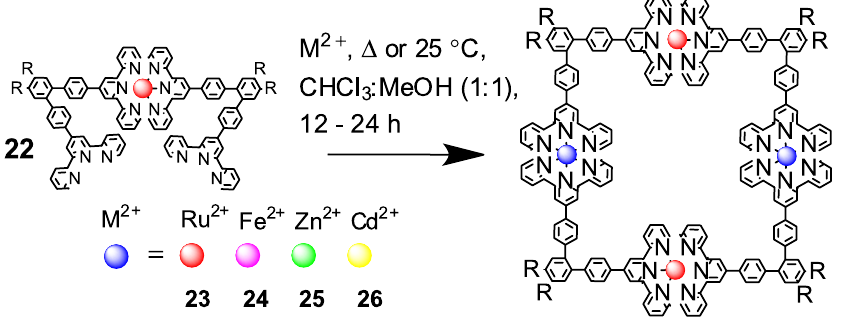
FIGURE 11 - Synthesis of a series of square-shaped metallocycles using a modified bis terpyridine to avoid trimer formation [Schultz, A.; Li, X.; McCusker, J. K.; Moorefield, C. N.; Castellano, F. N.; Wesdemiotis, C.; Newkome, G. R. Chem. Eur. J. , v.18,